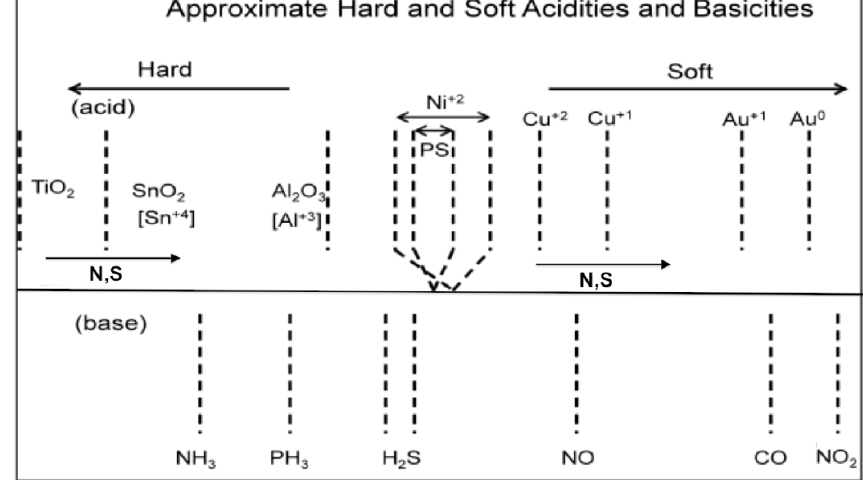
for ( a ), ( c ) and ( e ), 3 and NiO. x